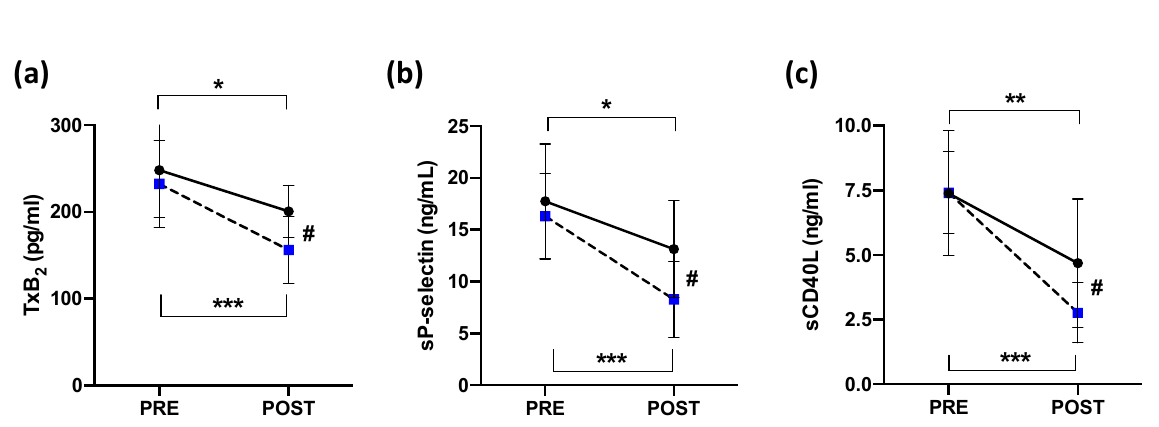
Figure 2. ( a ) Thromboxane B 2 production, ( b ) soluble P-selectin levels and ( c ) soluble CD40 ligand before and 15 days after administration of GLP-1RA ( n = 16) or gliflozins ( n = 16). Data are expressed as mean ± SD. Intra-group significance: * p < 0.05; ** p < 0.001; *** p < 0.0001; inter-group significance: # p < 0.05.